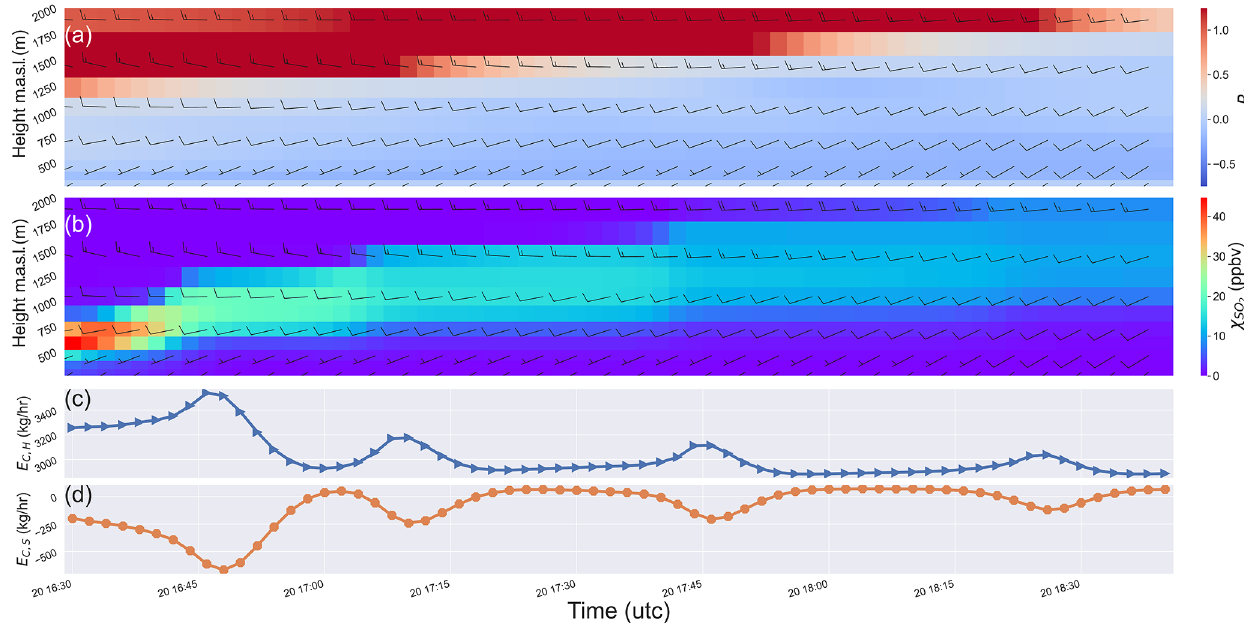
Figure 7. This schematic demonstrates (qualitatively) the correlation between change in atmospheric stability represented by the gradient Richardson number ( Ri ), plume vertical motion and storage-release events for the period of case 4. (a) Ri vertical profiles at stack location over the flight time, with the color-scale symmetric around the critical gradient Richardson number Ri C = 0 . 25. (b) SO 2 mixing ratio vertical profiles at stack location. (c) Time series of net horizontal flux ( E C , H ) and (d) the storage rate ( E C , S ), over sampling time. Note the level of anti-correlation between E C , H and E C , S ( P r = − 0 . 95); oscillations in storage and release are occurring: changes in E C , S are matched by opposite changes in E C , H . Wind speed and direction are shown as barb plots with units ms − 1 (half = 5, full = 10). For every incremental rise in plume height, a corresponding release event occurs. As the plume ascends into regions with faster wind speeds, more mass is released ( E C , S < 0) through the lateral walls resulting in an increase in E C , H as can be seen in (c)